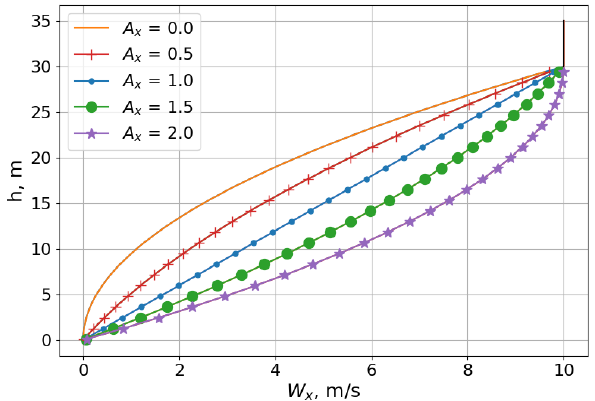
= 10 m/s and h tr x